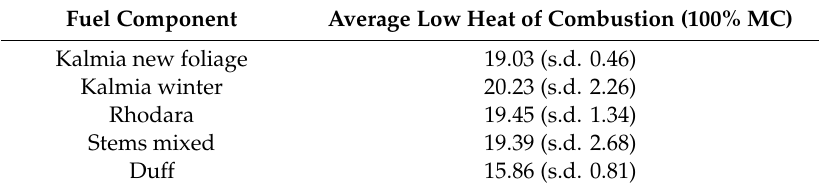
Table 2. Low heat of combustion measured for various components of the NS-1 fuel complex.